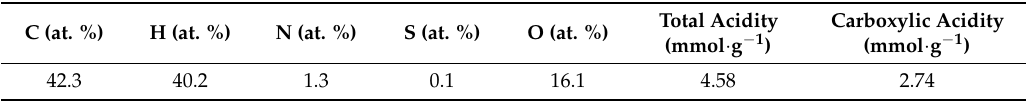
Table 1. Elemental composition, total acidity, and carboxylic acidity of humic acids. C (at. %) H (at.